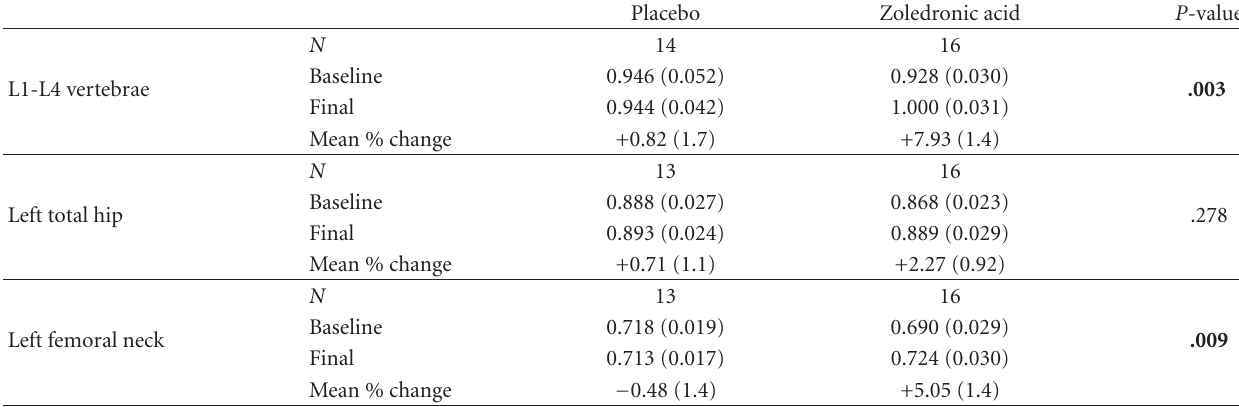
Table 1: Comparison of mean ± SE percent change in BMD from baseline to final in BMD (gm/cm 2 ) between two groups. A two-sided significance level of 0.05 is used for a two-sample t